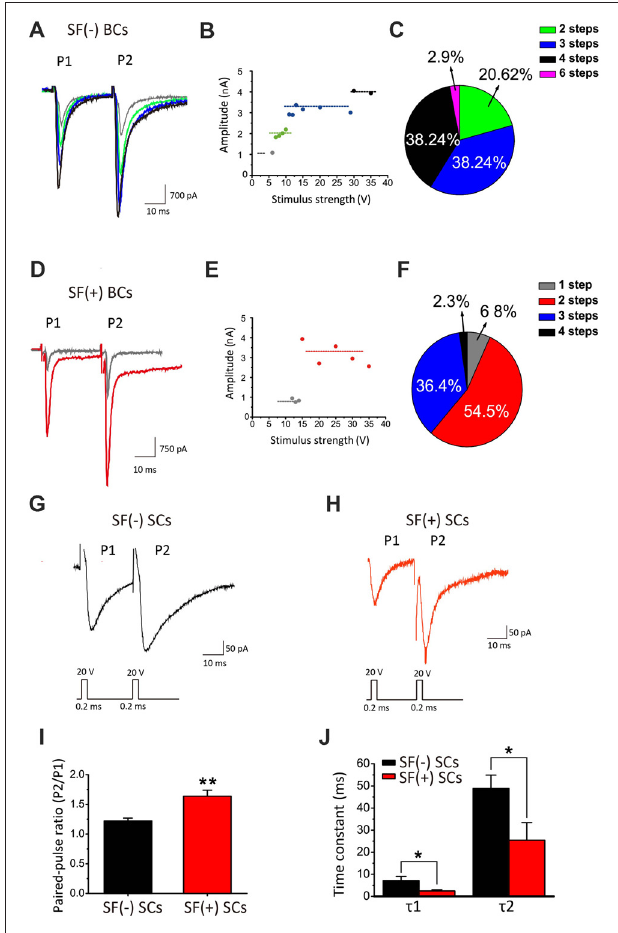
FIGURE 9 | SFs are correlated with accelerated maturation of functional connectivity and remodeling. (A) Example traces of evoked EPSCs recorded from a SF( − ) BC. (B) The amplitude of eEPSCs in different stimulus strength for this neuron increased in four distinct steps as shown in (A) . (C) Pie chart illustrating the relative fraction of BCs with different number of stepwise changes in response to increasing stimulation intensity. (D) Example traces of evoked EPSCs recorded from a SF(+) BC. (E) The amplitude of eEPSCs in different stimulus strength in this BC showed two stepwise increases. (F) Pie chart showing significant increases in the fraction of bushy cells with less than three stepwise changes when these neurons are primed by SFs. (G,H) Example traces of eEPSCs recorded from SF(+) and SF( − ) SCs. (I) Mean value of paired-pulse ratio (PPR) of EPSC charge in SF(+) and SF( − ) SCs. (J) Average time constants ( τ 1 and τ 2) from exponential fits to the decay phase of EPSCs from SF(+) and SF( − ) SCs. All recordings were made in the presence of stry and